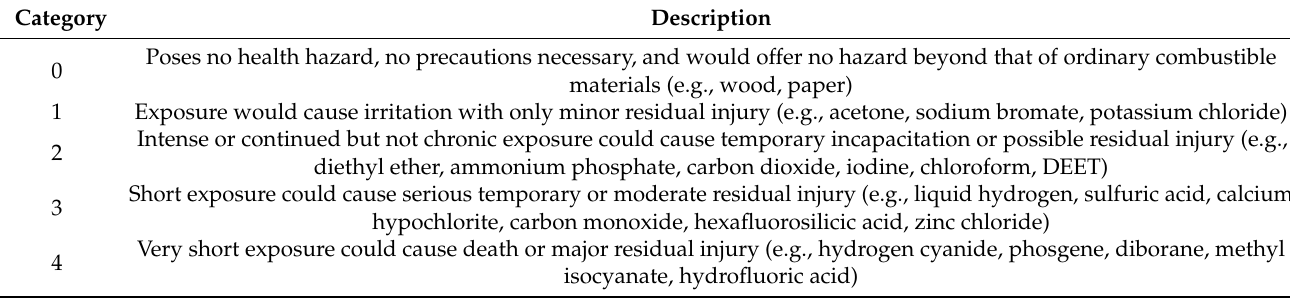
Table 1. NFPA 704 health